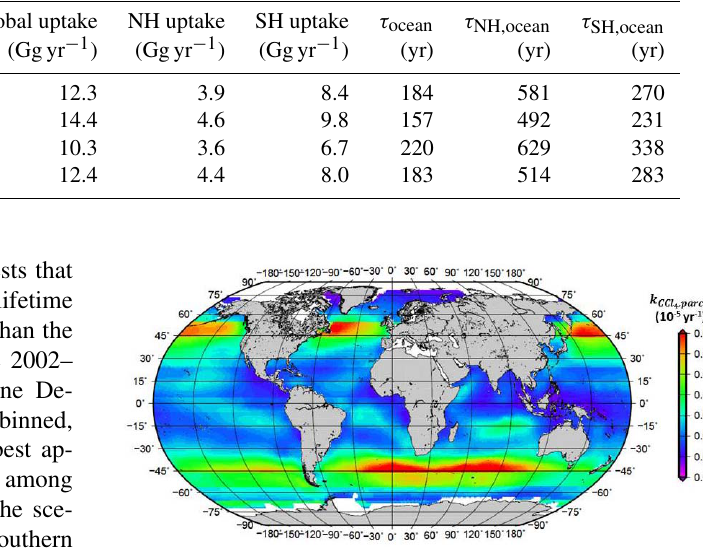
Figure 9. Global distribution of the oceanic uptake rate constant ) based on the mean zonal saturation anomalies (Fig. 5, ( k CCl 4 , parcel Table 3) and calculated monthly air–sea exchange rates and other parameters given in Eq. (3) for 1 ◦ × 1 ◦ cells of the Global Oceano- graphic Data Set Atlas, Climatologies (NOAA, 1988). Because the saturation anomaly is largely similar among zonal regions of the ocean, variability in removal of CCl 4 from the atmosphere is con- trolled primarily by wind speed, which is highest in higher latitudes of both